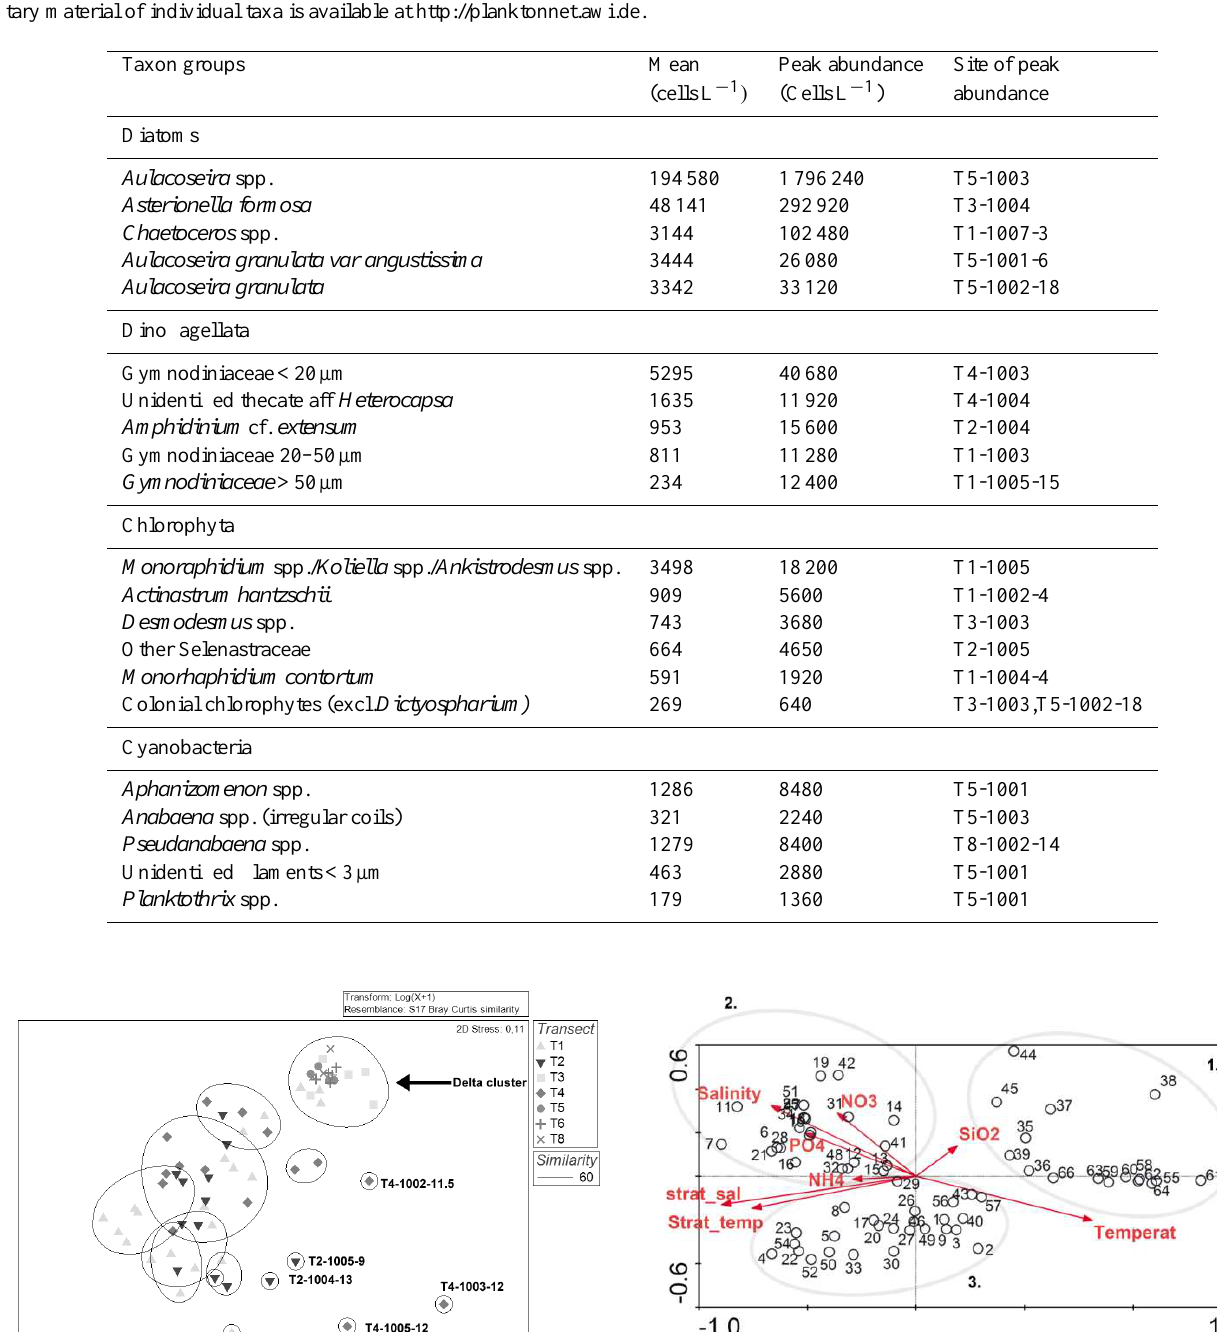
Table 2. Summary of the most abundant taxa in the different taxon groups together with their abundance averaged over all sites. Supplemen- tary material of individual taxa is available at http://planktonnet.awi.de.